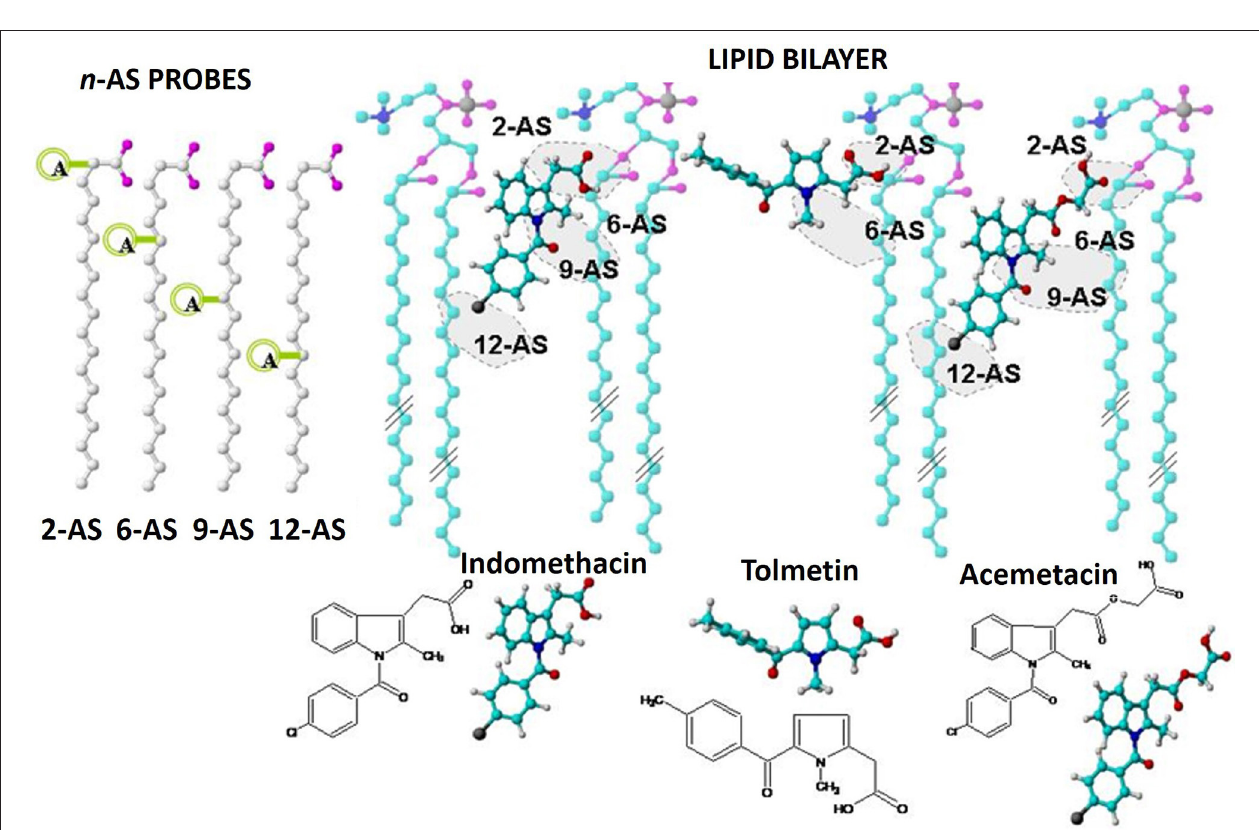
FIGURE 11 | Schematic representation of the possible location/orientation of Tolmetin, Acemetacin, and Indomethacin molecules within the lipid nanocarrier indicating the chemical groups likely responsible for fluorescence quenching of n -AS